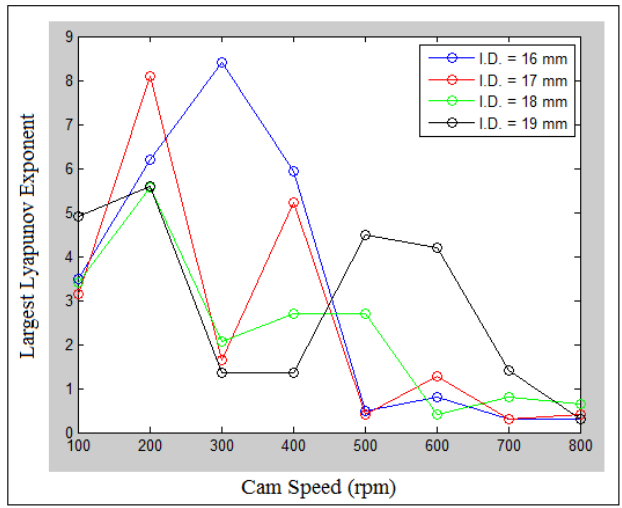
Figure 27. Largest Lyapunov exponent against cam speeds for cam profile no.(1).